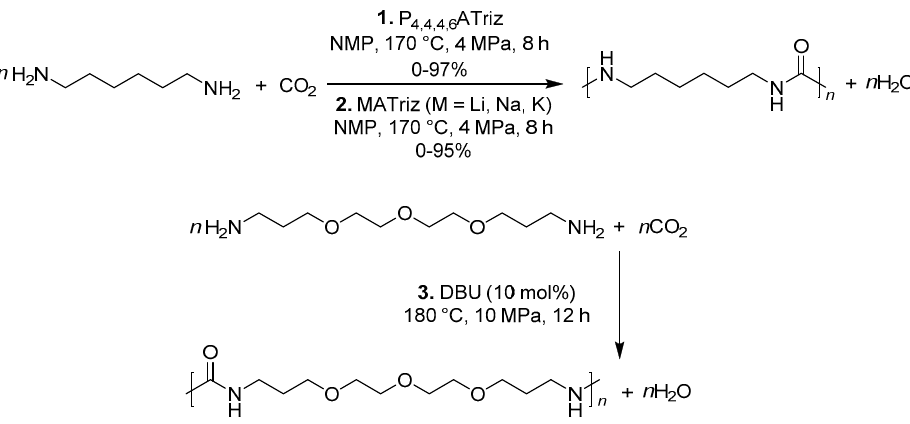
Figure 5. Various ureas by CeO 2 /NMP system. Reprinted with permission from [92] (Copyright 2015 Elsevier Inc.).